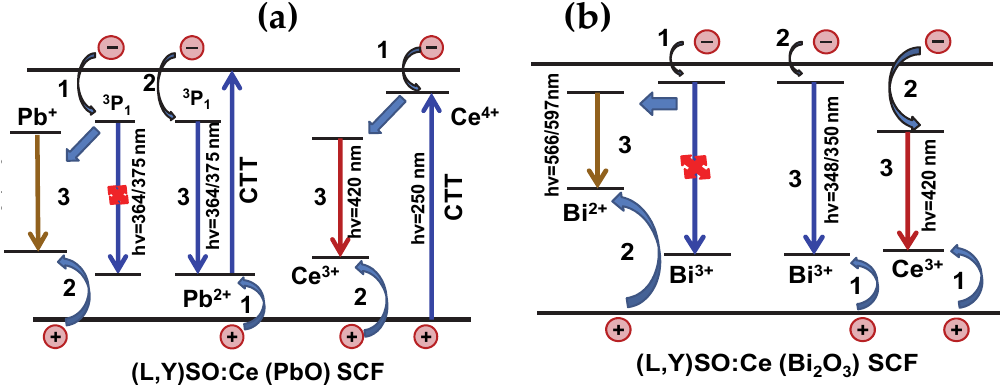
Figure 7. Difference in mechanisms of excitation of the luminescence of Ce 4+ and Ce 4+ centers as well as Pb 2+ and Bi 3+ centers in LSO:Ce and YSO:Ce SCFs grown from ( a ) PbO and ( b ) Bi 2 O 3 based fluxes, respectively.